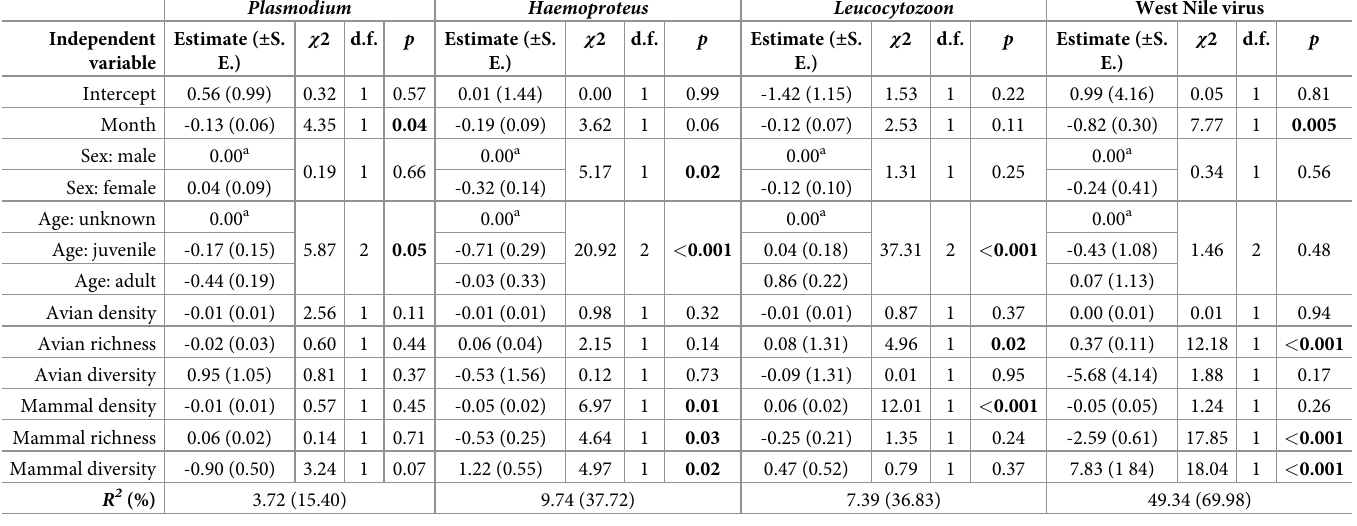
Table 1. Results of the GLMMs testing the relationships between the prevalence of avian malaria Plasmodium , the related Haemoproteus and Leucocytozoon para- sites (N = 2,588), and the seroprevalence of WNV (N = 2,544), and individual characteristics of house sparrows (age, sex, and month of capture), avian and mammal species density, richness (estimated from a rarefaction curve) and diversity (calculated as evenness index). Significant relationships ( p � 0.05) are highlighted in bold; conditional and marginal (in brackets) R 2 variance are shown. Plasmodium Haemoproteus Leucocytozoon West Nile virus Independent Estimate ( ± S. variable E.)